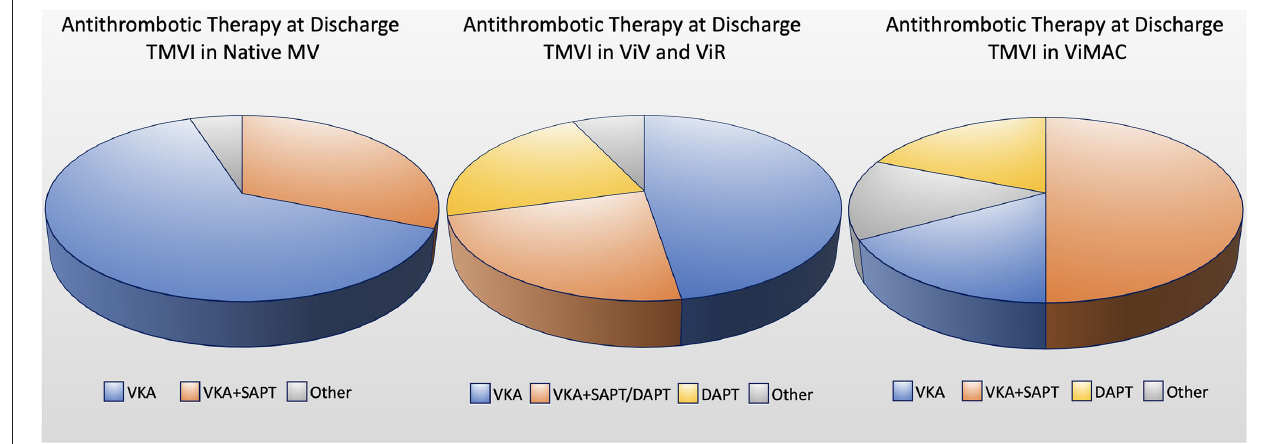
FIGURE 3 | Circle chart showing the anticoagulant/antiplatelet therapy at discharge for TMVI in native mitral valve, valve-in-valve (ViV), valve-in-ring (ViR) and valve-in-mitral annular calcification (ViMAC) [data based on Ref. ( 33)]. DAPT, double antiplatelet therapy; SAPT, single antiplatelet therapy; VKA, vitamin K antagonist.